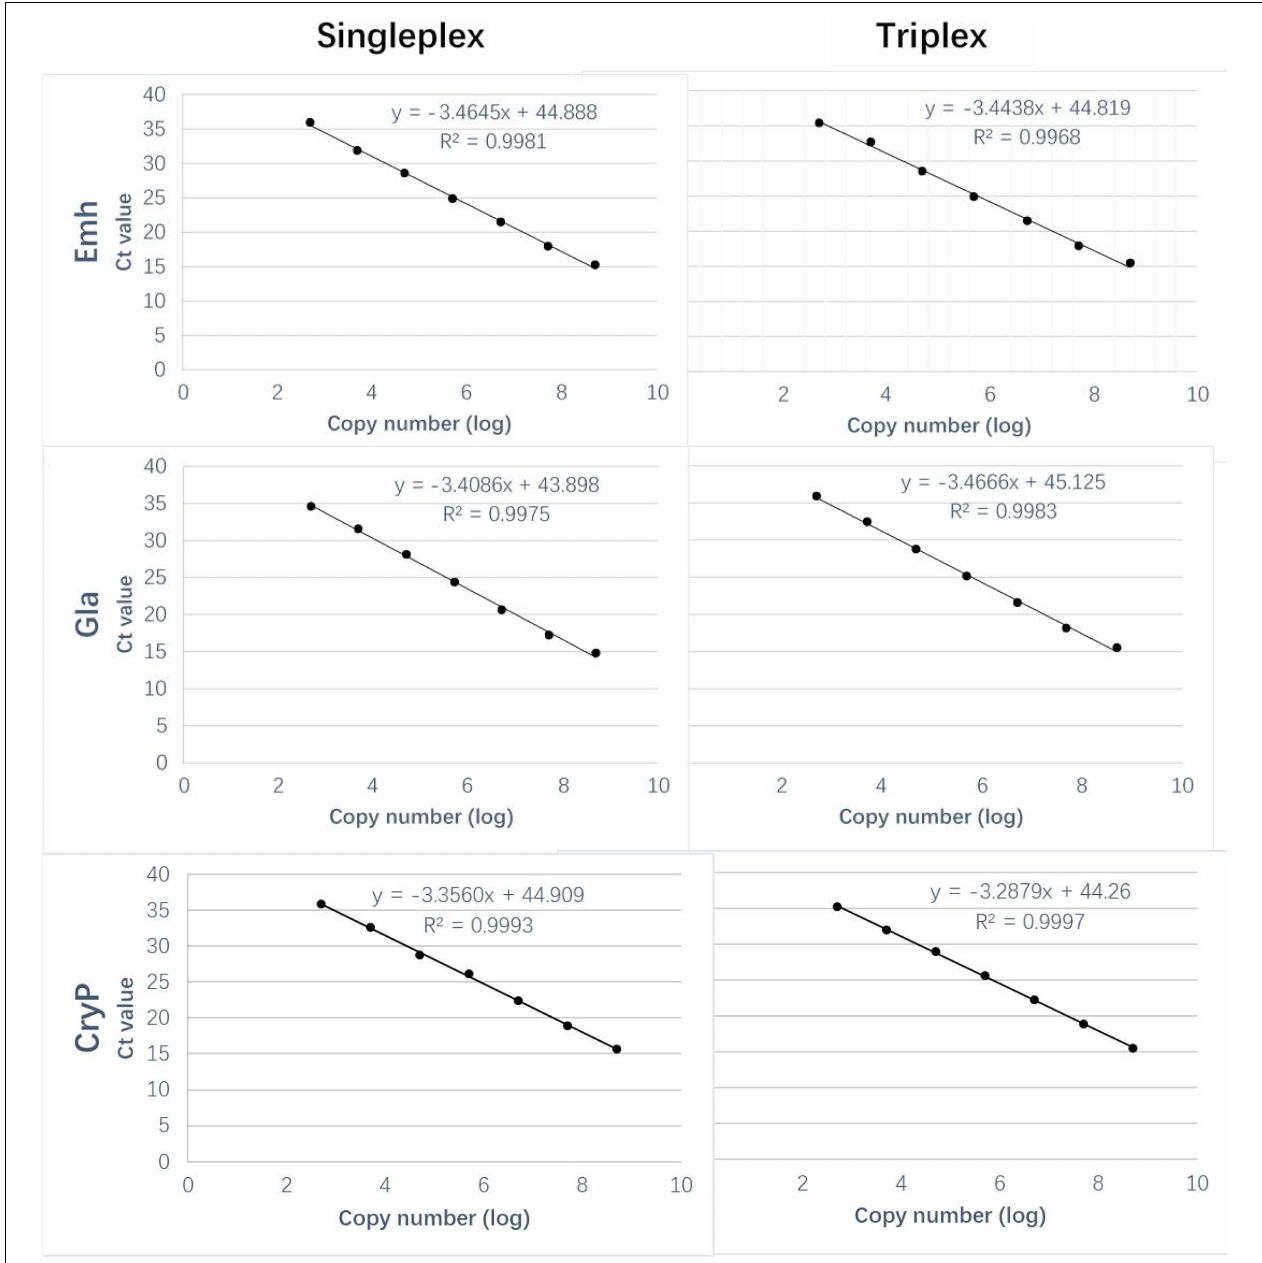
FIGURE 1 | Comparison of the standard curves of the singleplex and triplex Quantitative PCR (qPCR) assays. Ct, cycle threshold.